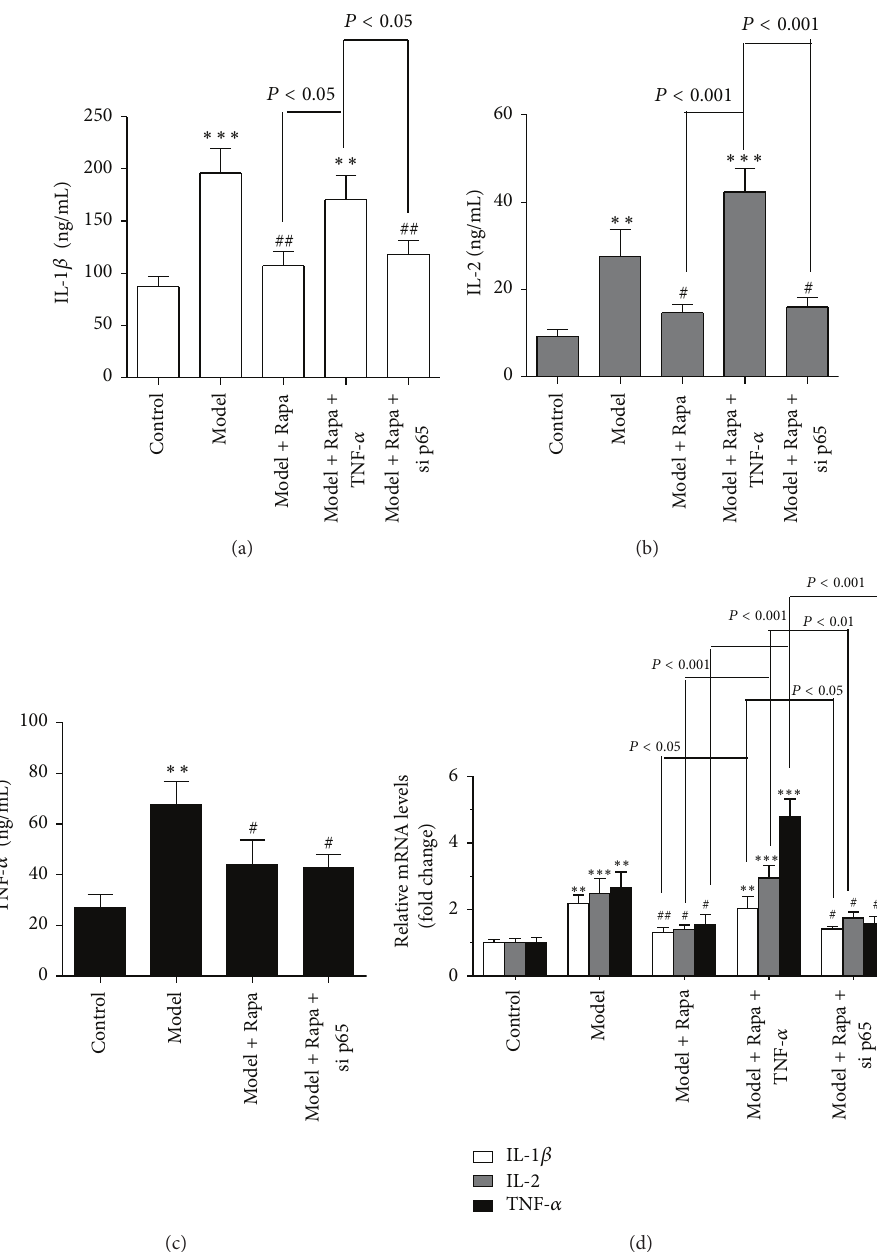
Figure 3: NF- 𝜅 B participates in the role of Rapa in reducing pro-inflammatory cytokines release and gene expressions in cardiomyocytes ((a), (b), and (c)) ELISA was used to determine the release of IL-1 𝛽 , IL-2 and TNF- 𝛼 into the cultured medium. (d) Real-time PCR analysis was performed to quantify the mRNA levels of proinflammatory cytokines. The mRNA was prepared and normalized to 𝛽 -actin gene. 𝑛 = 3 experiments in duplicate. Error bars, SD. ∗∗ 𝑃 < 0.01 versus control group; ∗∗∗ 𝑃 < 0.001 versus control group; # 𝑃 < 0.05 versus model group; and ## 𝑃 < 0.01 versus model